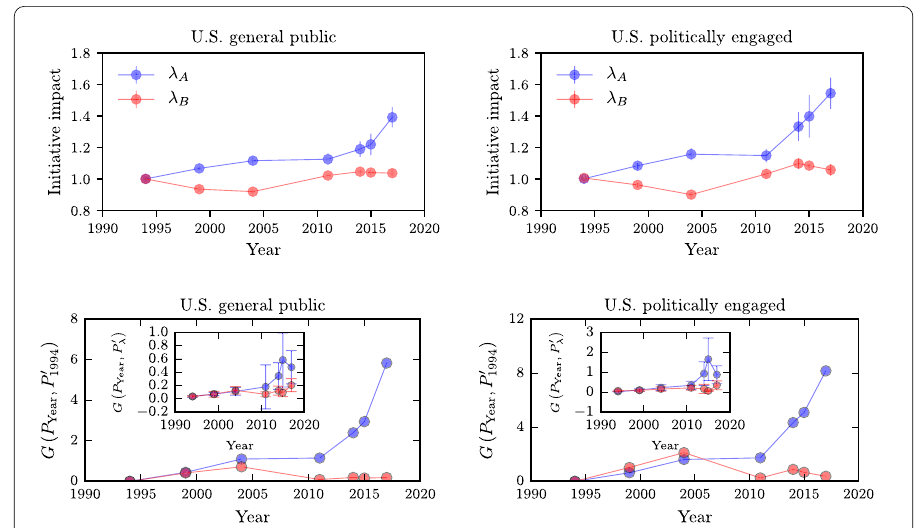
Figure 6 Initiative impacts and relative entropy over different years. In the upper panels, we show estimates of the initiative impact λ A and λ B as defined in Eqs. (10) and (11). We see that the polarization effects for self-identified Democrats are larger than for self-identified Republicans. We also compute the relative entropy usning Eq. (14) and show the results in the lower panels. P Year , P (cid:5) 1994 and P (cid:5) λ are the distributions of the data in different years, of the model in 1994 and of our model in different years, respectively. Blue disks represent Democrats and red disks represent